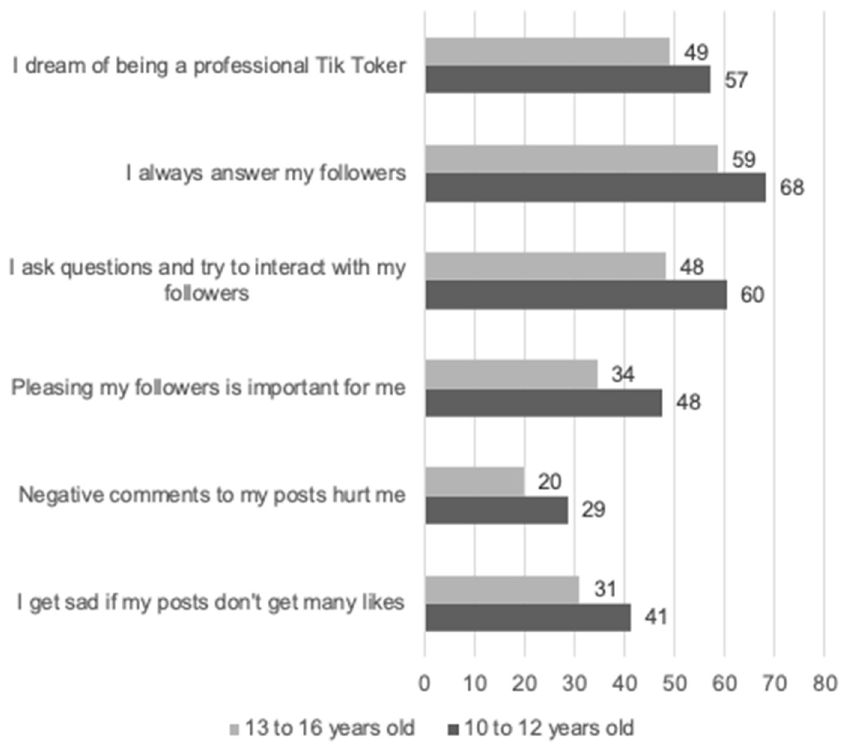
Figure 12. TikTok users who agree with expressions concerning gratifications afforded by publishing original content on the platform, by age (in percentage).